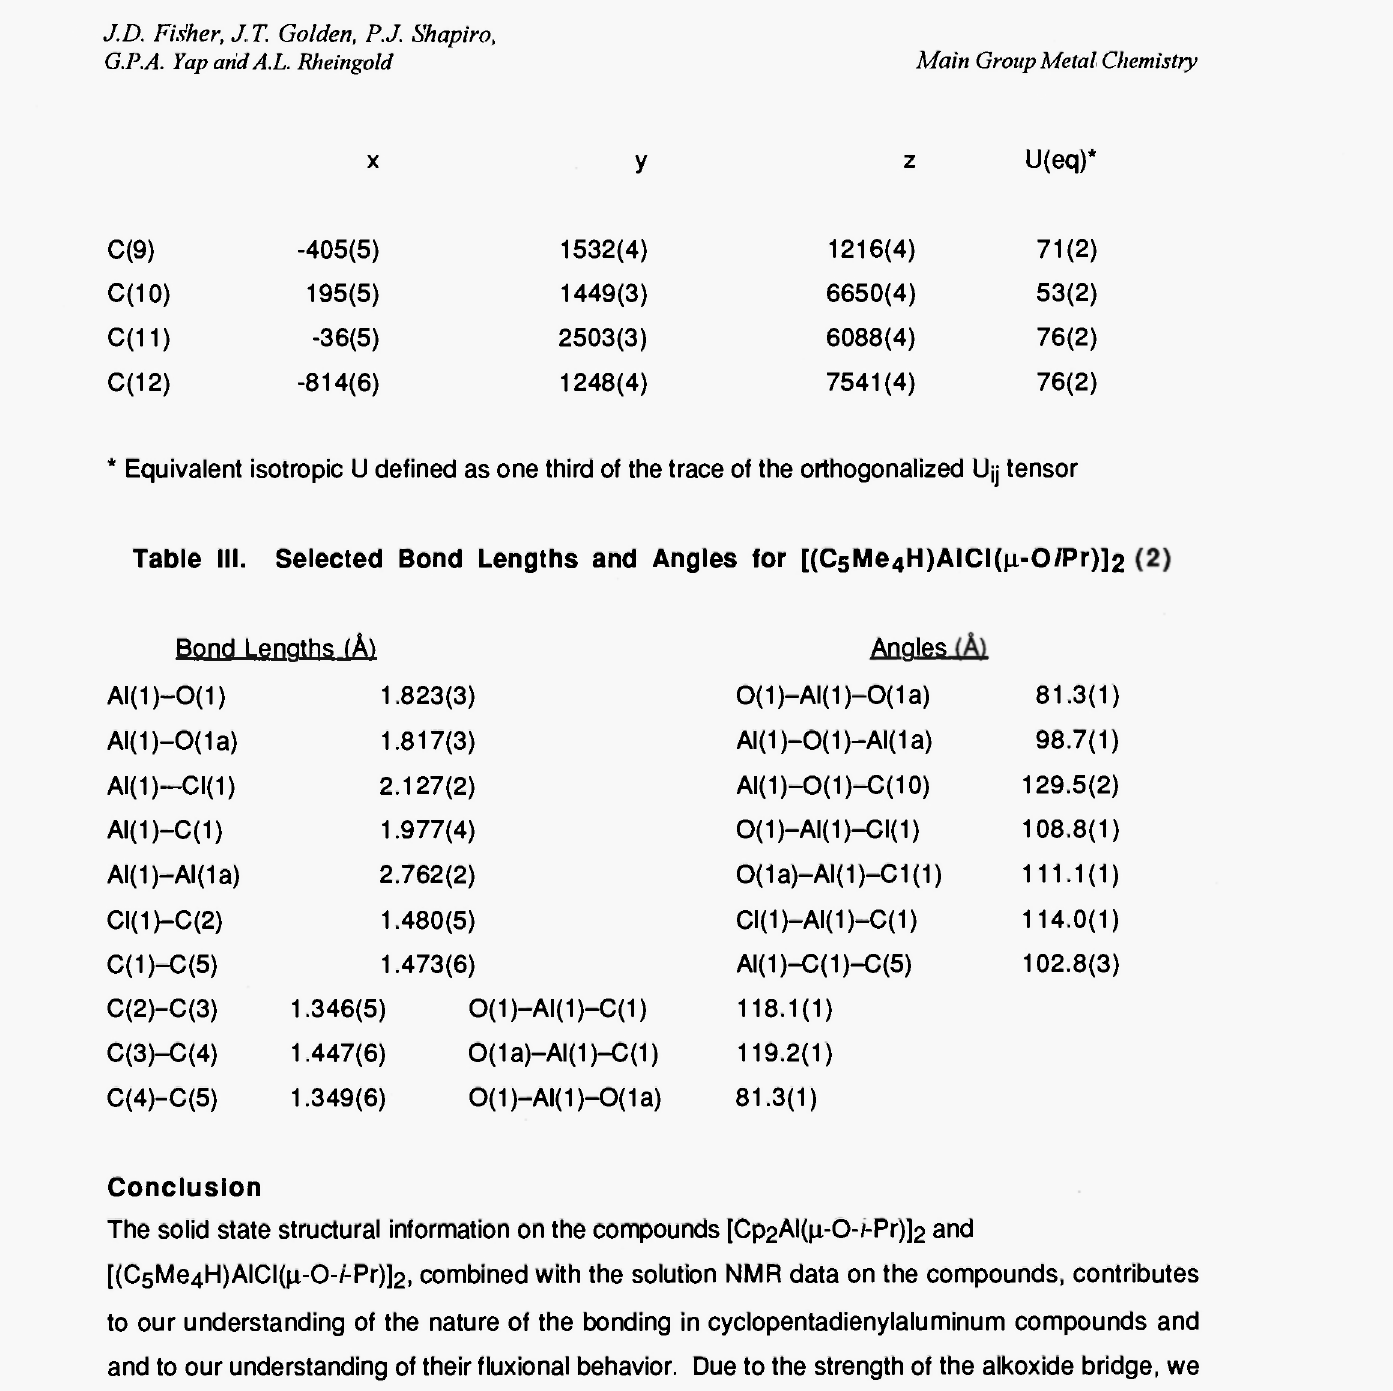
Table III. Selected Bond Lengths and Angles for [(C5Me